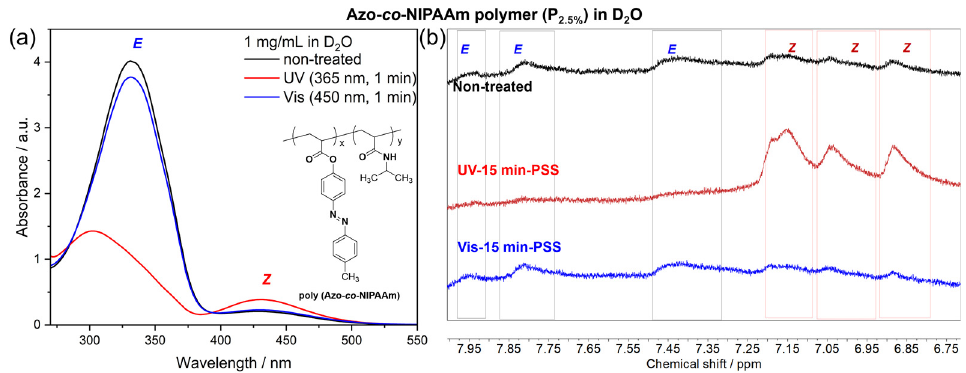
Figure 3. ( a ) UV-vis spectra of the Azo- co -NIPAAm polymer, P 2.5% , effectively switching in D 2 O (1 mg/mL) and retaining the photochromic properties in aqueous medium; ( b ) 1 H NMR spectra of the polymer P 2.5% in D 2 O (10 mg/mL), indicating a mixture of 68% ( E ) and 32% ( Z ) in the non-treated state, an enriched ( Z ) isomer after irradiation with UV light (red), and a mixed form when back-switched with vis light (blue).